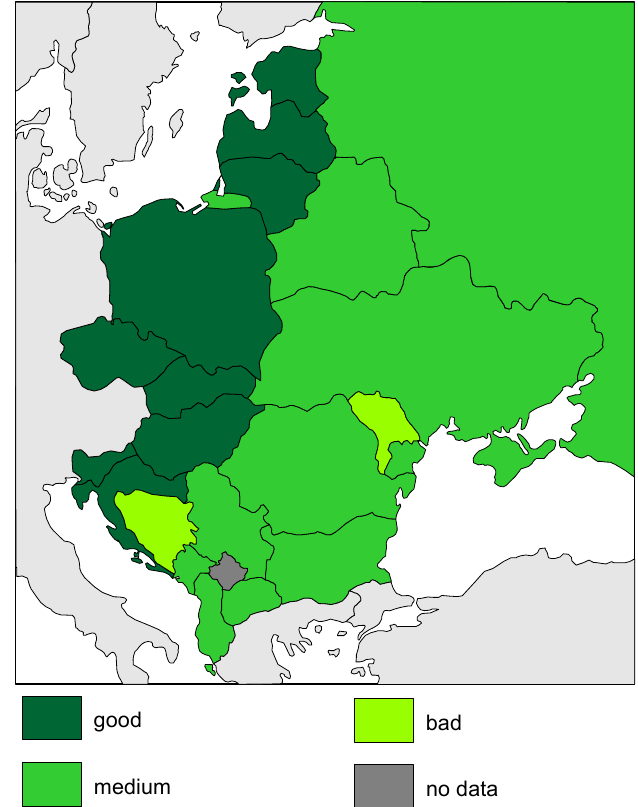
Fig. 4. An overall assessment for the situation of the populations in European post-communist countries in 2013/2014 (source: own elaboration based on distributed